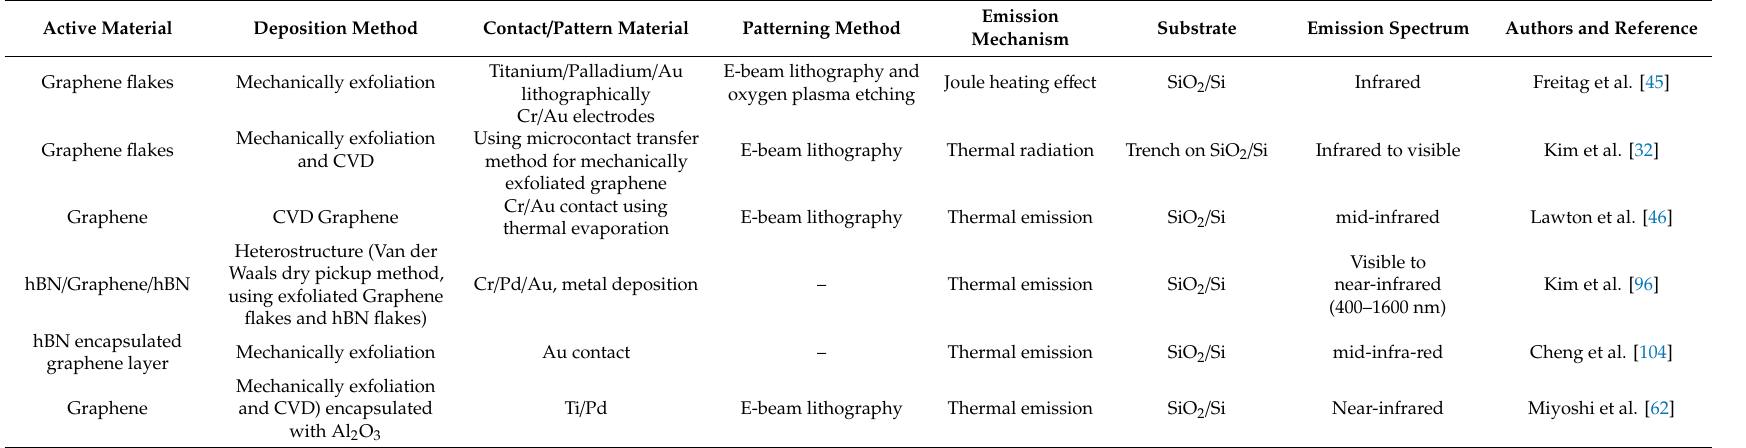
Table 1. Summary of the graphene-based thermal